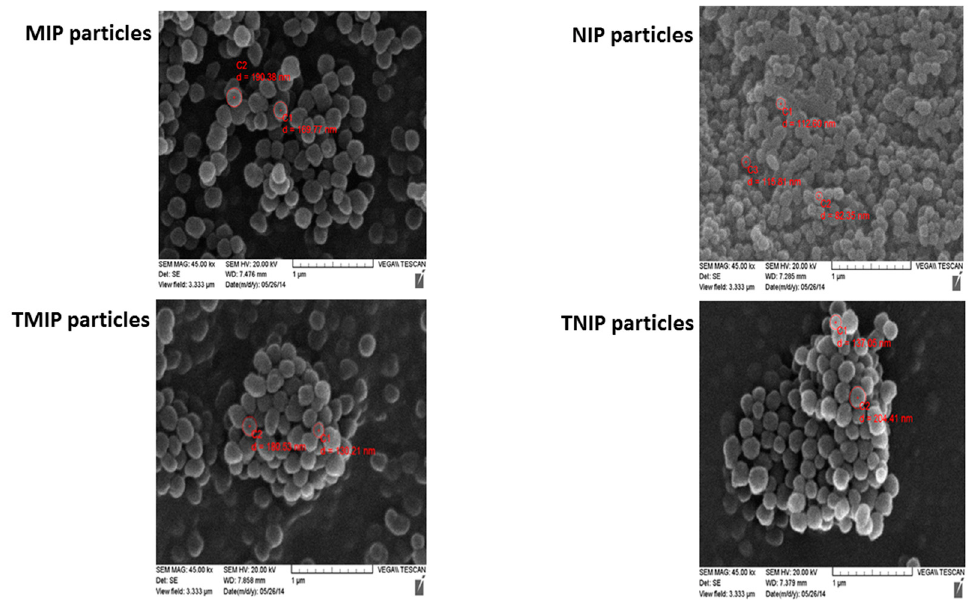
Figure 5. Scanning electron microscopy images of MIP, NIP, TMIP and TNIP particles.